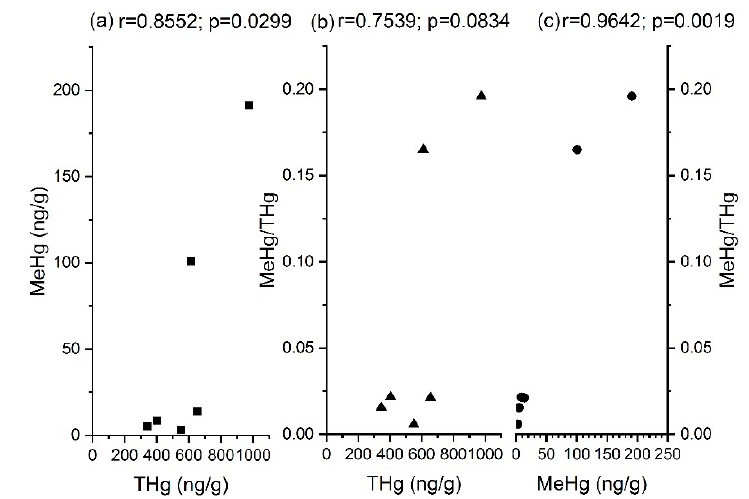
Figure 3. Correlation between THg and MeHg: ( a ) Relation between THg and MeHg; ( b ) Relation between THg and MeHg/THg; ( c ) Relation between MeHg and MeHg/THg.